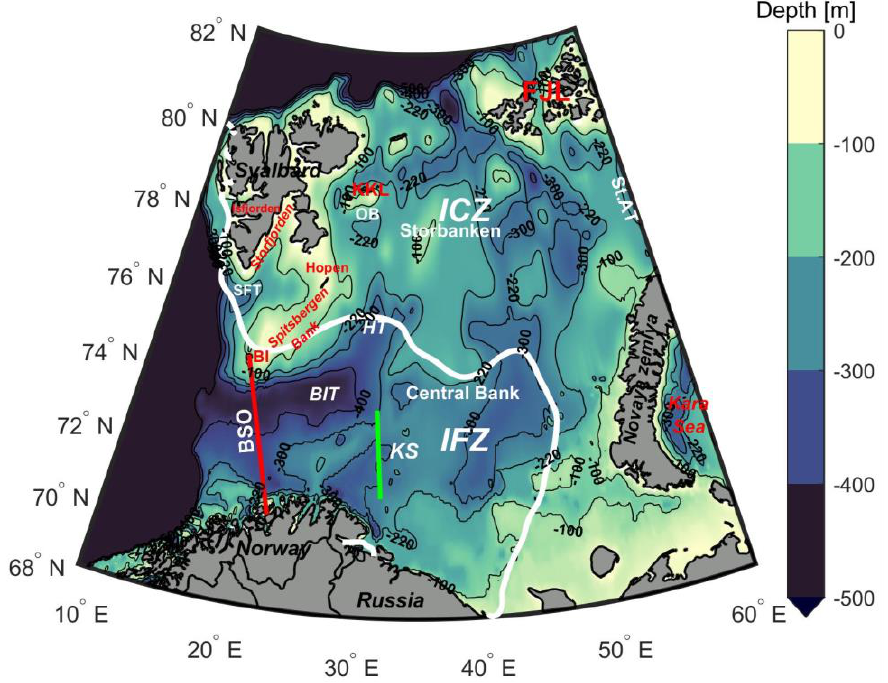
Figure 1. Map of the Barents Sea with bathymetry (GEBCO, https://www.gebco.net (accessed on 30 May 2022)). The Barents Sea was divided into two regions: the ice-covered zone (ICZ, in the north), and the ice-free zone (IFZ, in the south), based on the climatological mean of the April sea-ice concentration edge (15% SIC, solid white line) for the entire period (1982 – 2020). Isobaths of 100, 220, 300, and 500 m are shown in black. Abbreviations stand for the Barents Sea Opening (BSO), Bear Island Trough (BIT), Hopen Trough (HT), Bear Island (BI), Storfjorden Trough (SFT), Kong Karls Land (KKL), Olga Basin (OB), Franz Joseph Land (FJL), and the St. Anna Trough (St.AT). The Kola Section (KS) is marked with a straight green line.